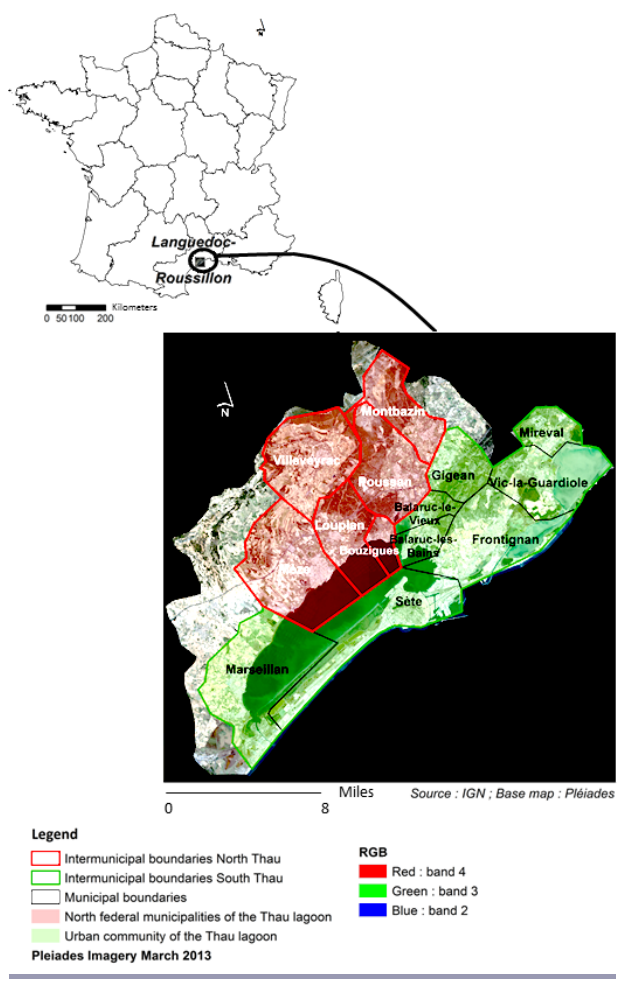
Fig. 1 . Case study